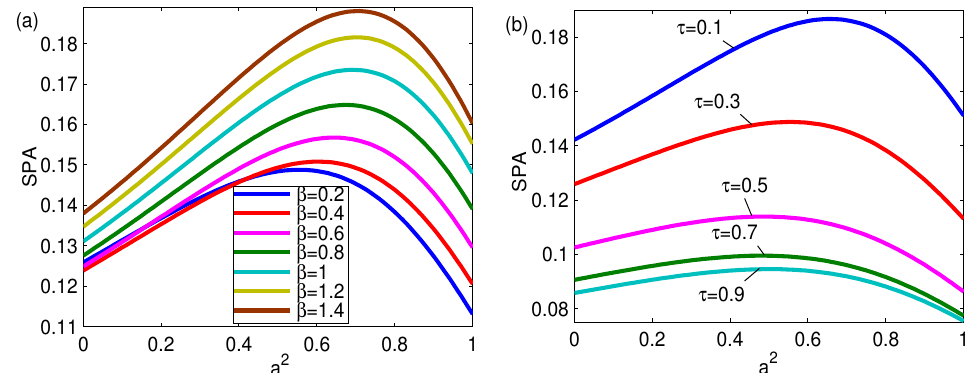
Figure 10. GSR behaviors of SPA( a 2 ) in (35) for different ( a ) β and ( b ) τ . ( a ) α = 1.2, ¯ γ = 0.1, δ = 1.6, τ = 0.3, q = 0.3, λ = 0.6, ω 0 = 1, Ω = 2, µ = ν = 0.8; ( b ) α = 1.2, β = 0.2, ¯ γ = 0.1, δ = 1.6, q = 0.3, λ = 0.6, ω 0 = 1, Ω = 2, µ = ν = 0.8.